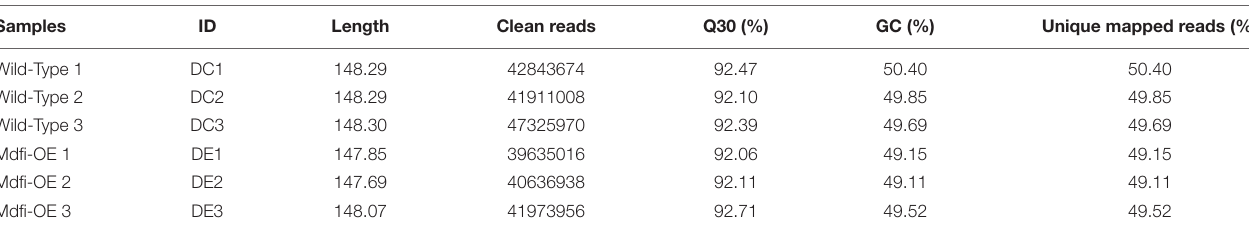
FIGURE 3 | Characteristics of differentiation and muscle fiber types in C2C12 cells with Mdfi overexpression. (A) Representative images of differentiating wild-type and overexpressing Mdfi C2C12 cells on days 1, 3, 5, and 7 in white light or myosin immunofluorescent staining. Myosin: red, a molecular marker of myogenesis; DAPI: blue, cell nuclei; Merge: the C2C12 cells fused into primary myotubes are shown in the insets. (B) Quantitative diagram of the percentage of myosin-positive C2C12 cells. (C) MyHC I, MyHC IIa, and MyHC IIb immunofluorescence staining in WT and Mdfi-OE C2C12 cells, respectively. (D) Quantitative diagram of the percentage of MyHC I, MyHC IIa, and MyHC IIb-positive C2C12 cells. The results are presented as Mean ± SEM of three replicates for each group. Magnification 200 × . The scale bar on the photomicrographs represents 25 µ m. TABLE 1 | Overview of mRNA sequencing